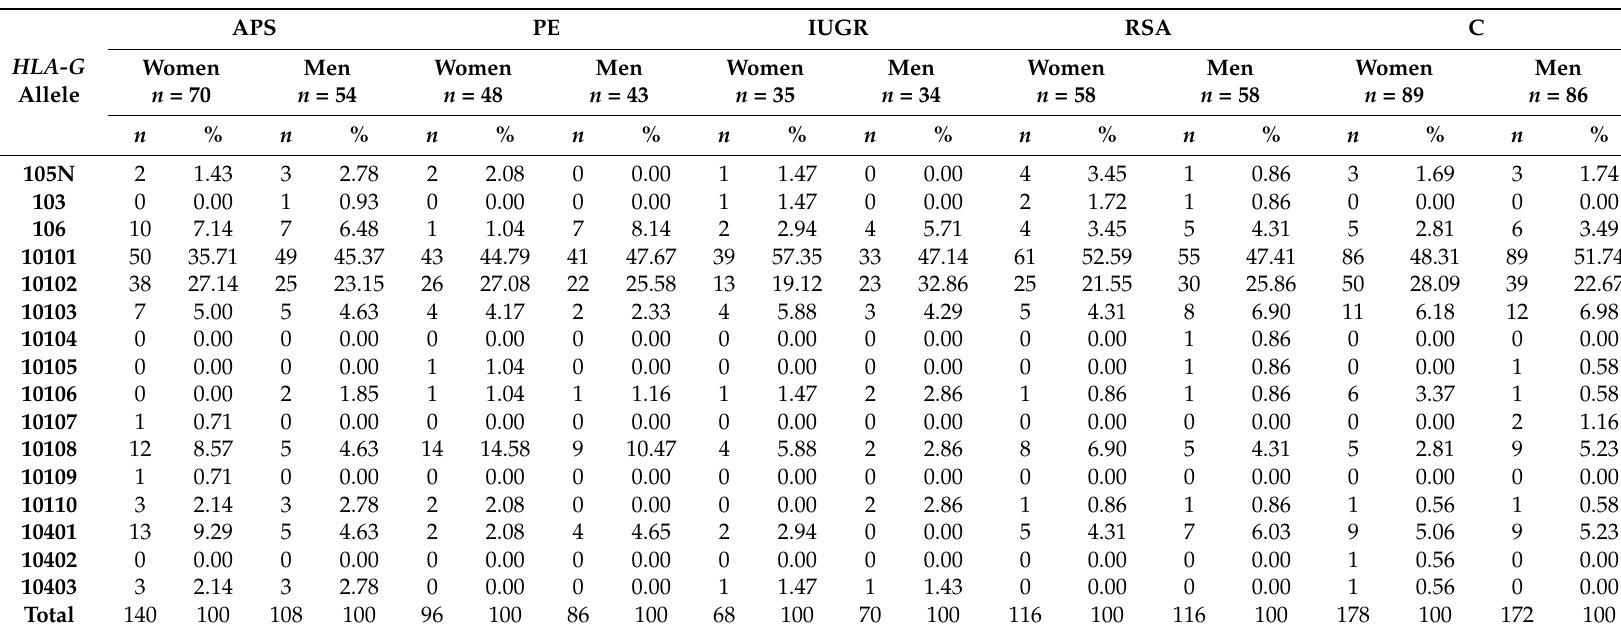
Table 4. The HLA-G allele frequencies in the women and men with antiphospholipid syndrome (APS), preeclampsia (PE), intrauterine growth restriction (IUGR), recurrent spontaneous abortion (RSA), and the control group